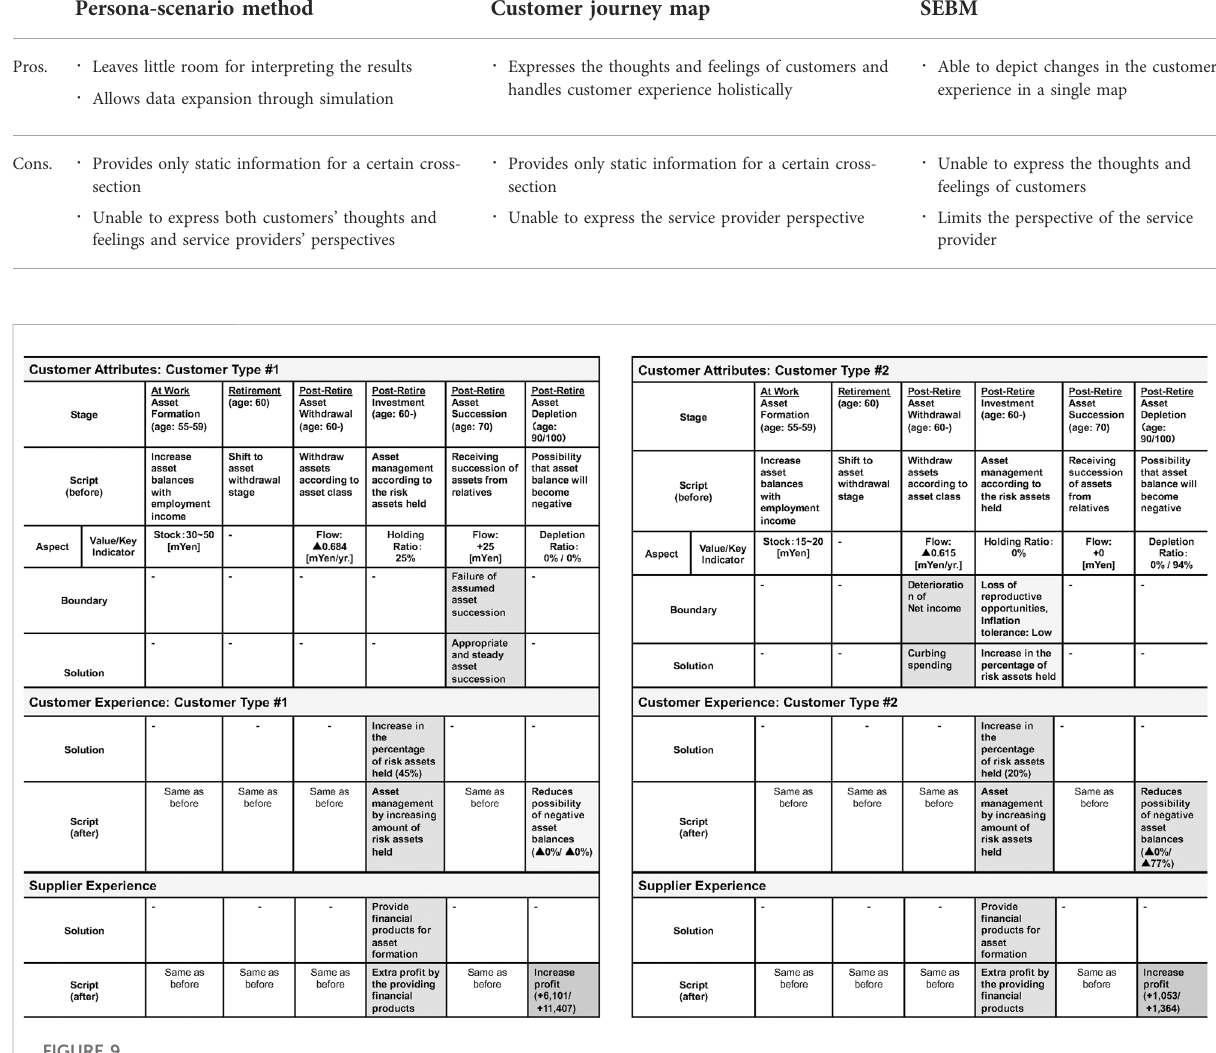
TABLE 2 Pros and cons of ordinary experience mapping